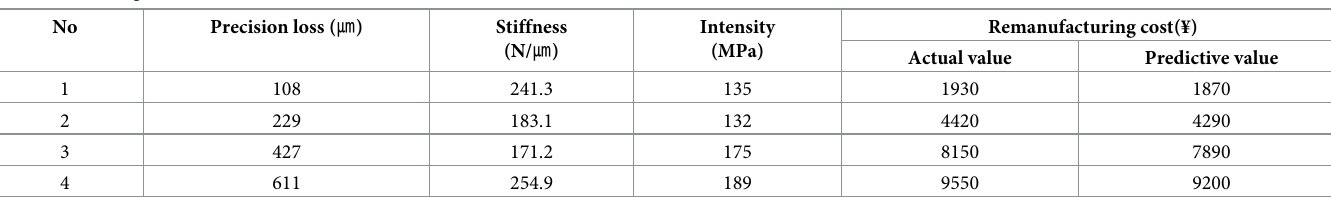
Table 3. Training effect of ANN.